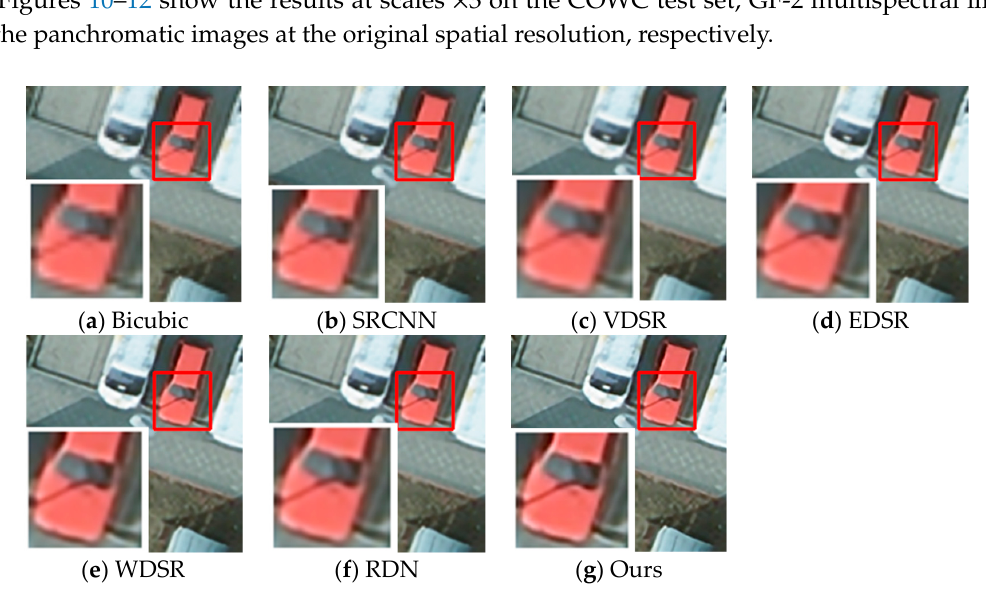
Figure 10. Qualitative comparisons of our model with other methods at the scale of ×3 on the COWC test sets at the original scale.